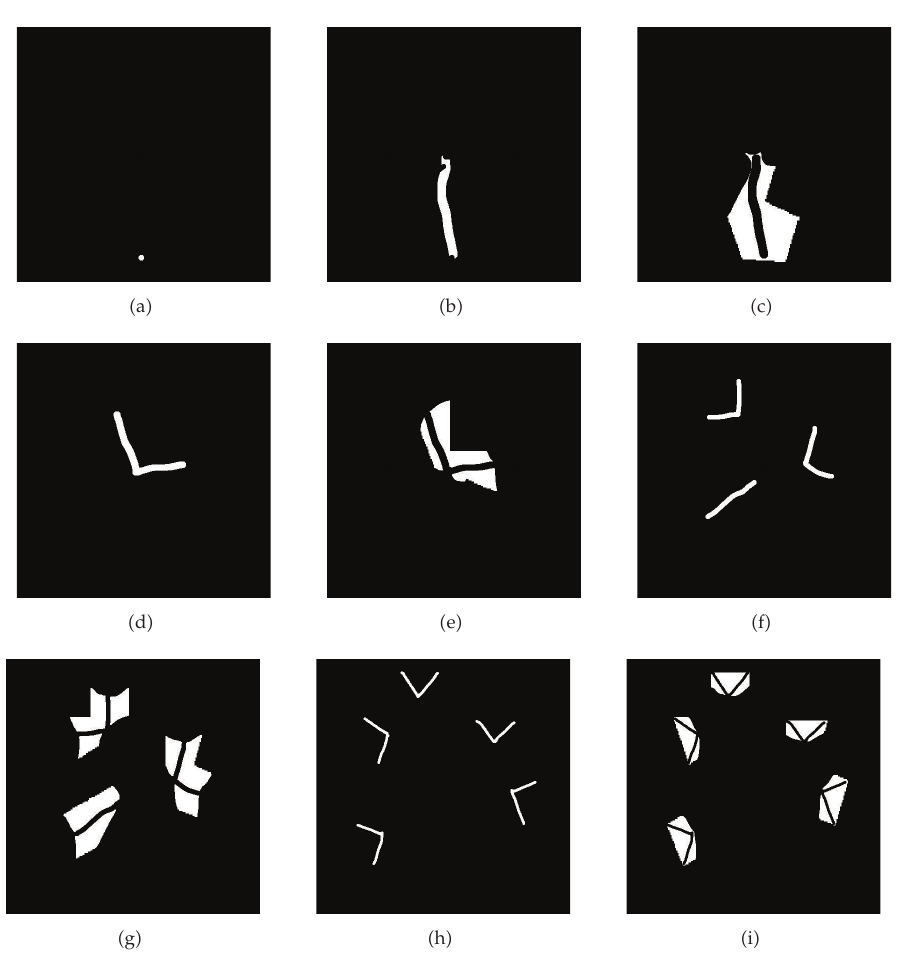
Figure 3: Synthetic tidal basin shown in Figure 1 (cid:2) c (cid:3) —that consists of channelized and nonchannelized regions—after decomposing into sets. (cid:2) a (cid:3) – (cid:2) i (cid:3) sets representing channelized and nonchannelized regions of which the mean elevations increase from S 1 to S 9 . The sets with even- and odd-numbered indexes, respectively, represent the zones occupied by channelized and nonchannelized